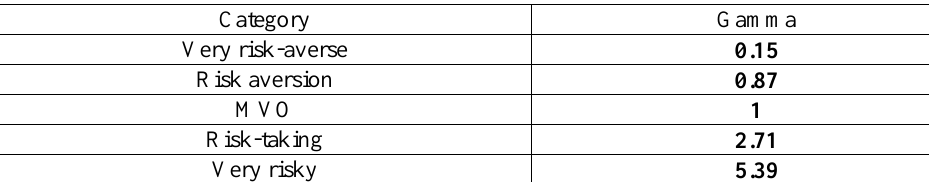
Table 3. Results of analysis of variance (research findings)